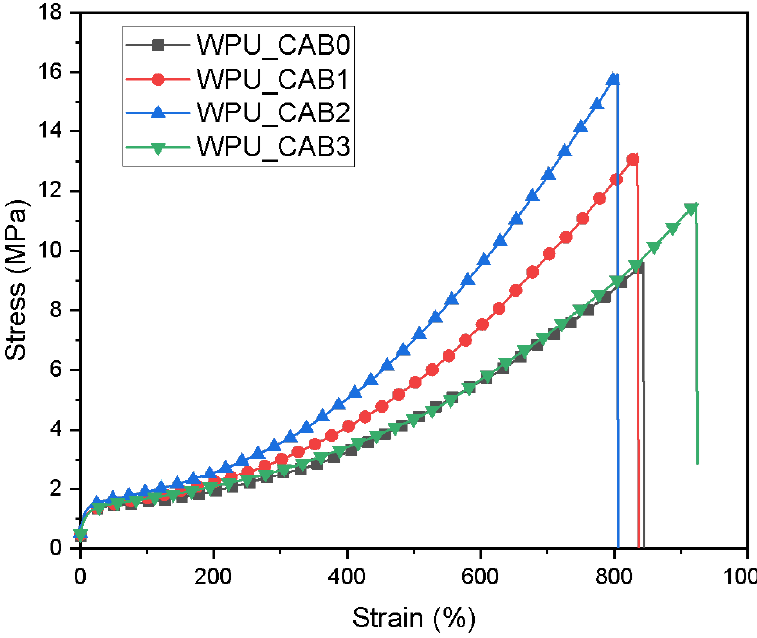
Figure 6. Stress – strain curves of WPU films with different CAB contents. Figure 6. Stress–strain curves of WPU films with different CAB contents. Table 4. Mechanical properties of WPU films.